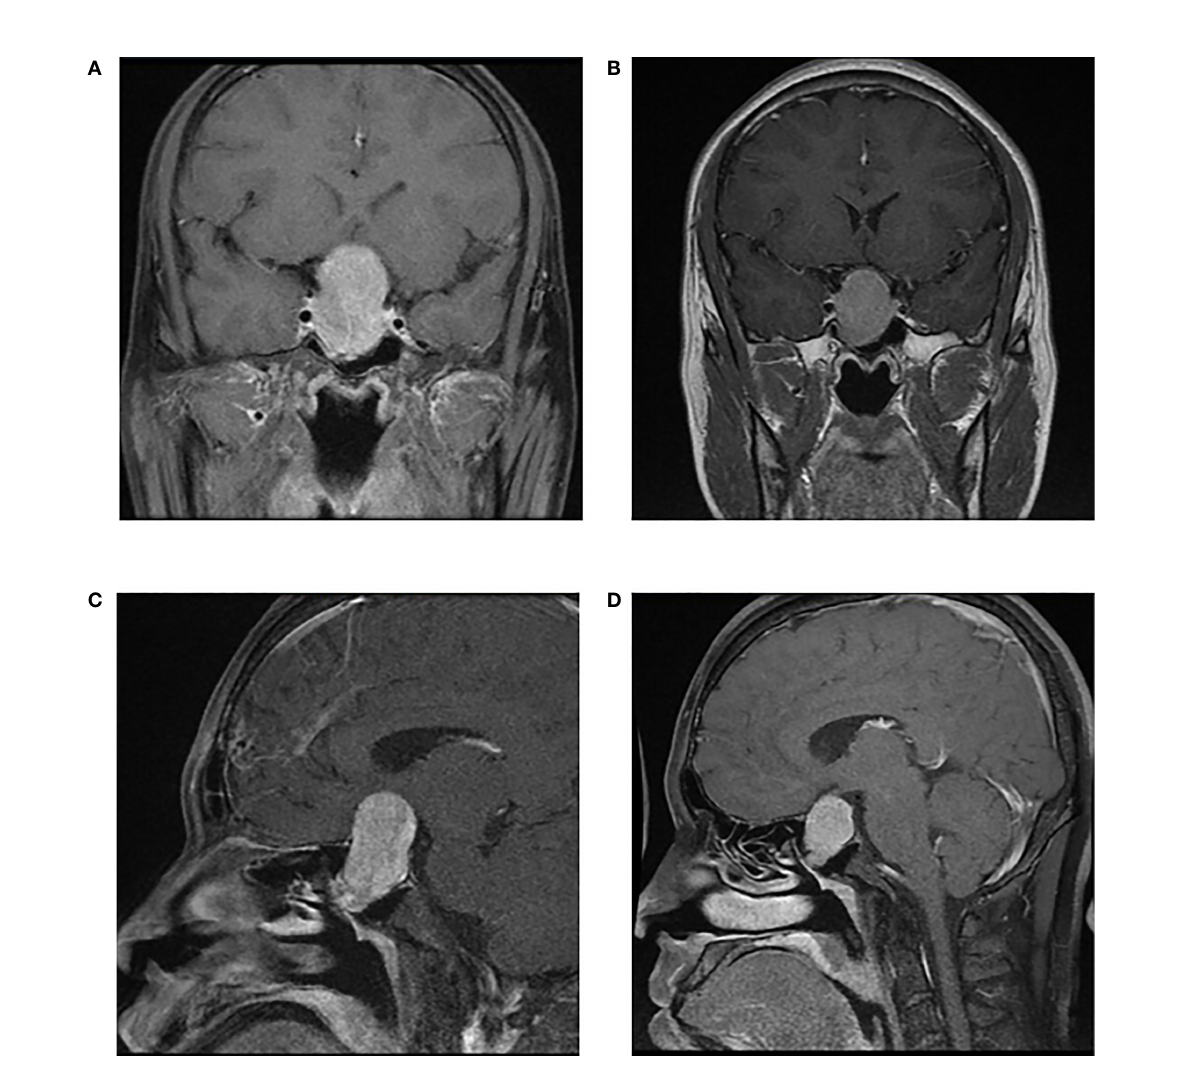
FIGURE 2 A patient with macroadenoma (46.7×27.7×23.5mm) received long-term SSA (Sandostatin LAR) for 12 weeks and achieved tumor shrinkage (34.2×24.8×20.9mm). Thyroid functions reduced to normal ranges after 4 weeks of medication. However, tumor was in tough texture examined in surgery and rather hard to resect due to long duration of SSA use. | Enhanced Pituitary MRI before SSA: (A) axial view and (C) sagittal view; Enhanced Pituitary MRI after SSA: (B) axial view and (D) sagittal